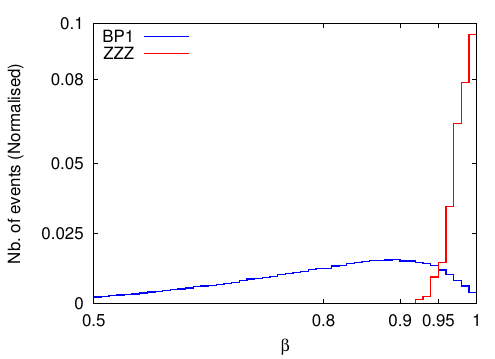
Figure 2 . (cid:12) -distribution for signals as well as background events are shown. The distribution clearly suggests that a negligible number of background events survives after the application of the (cid:12) -cut as mentioned in the